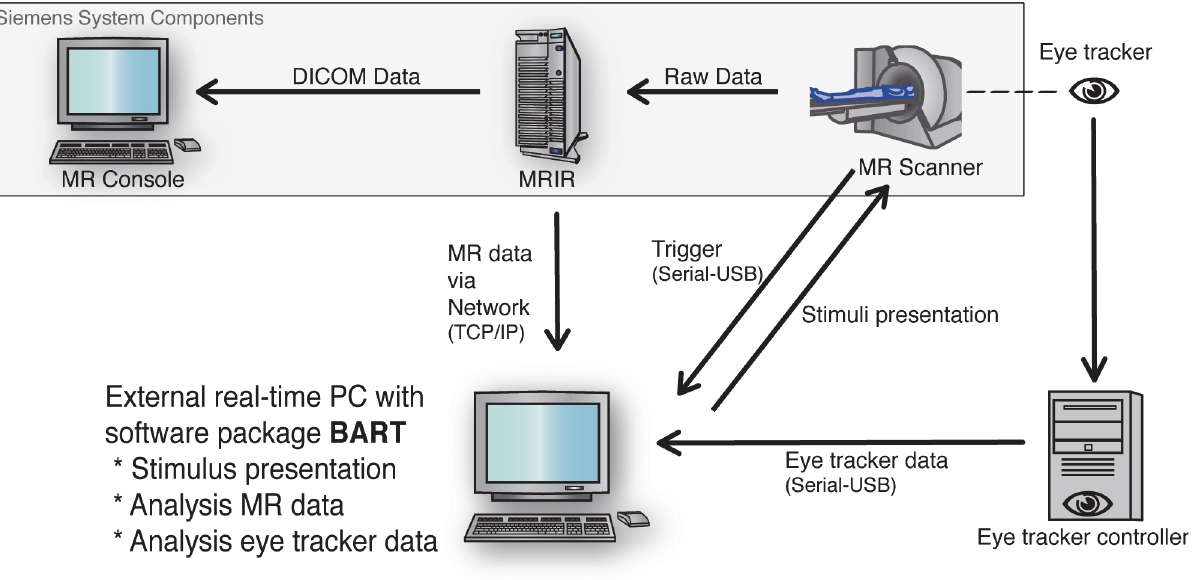
Fig 2. The experimental setup. A single external computer equipped with BART is connected with the internal Siemens reconstruction computer. This runs a custom-made software tool that sends MR data via network connection directly to the external instance. Additionally, eye tracker data are sent to this computer. They are computed in parallel to MRI data, the stimulus presentation, and the paradigm